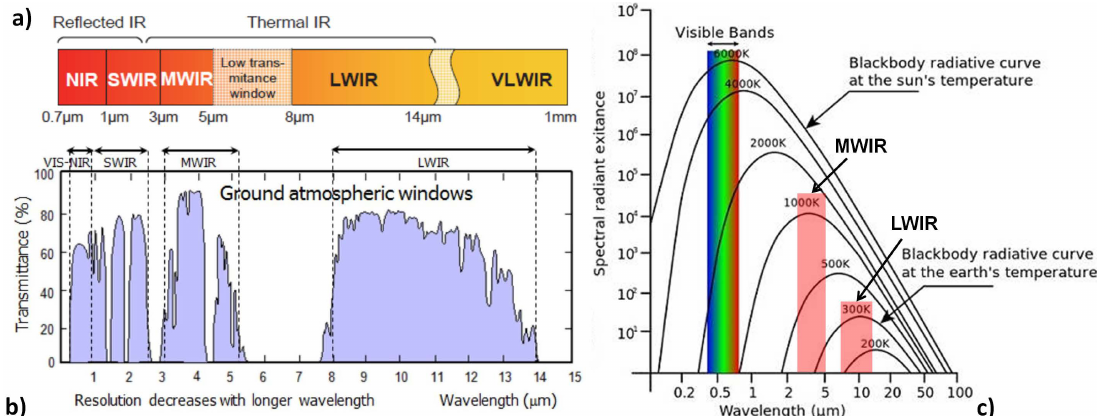
Figure 1. The infrared region of the electromagnetic spectrum ( a ) after [54]; ( b ) the spectral region between 0 and 15 µ m, with the atmospheric windows and the infrared bands regions after [55]; ( c ) spectral distribution of energy radiated from blackbodies of various temperatures: red squares highlight the infrared bands used by the sensors of modern thermal cameras (Image credit: Ant